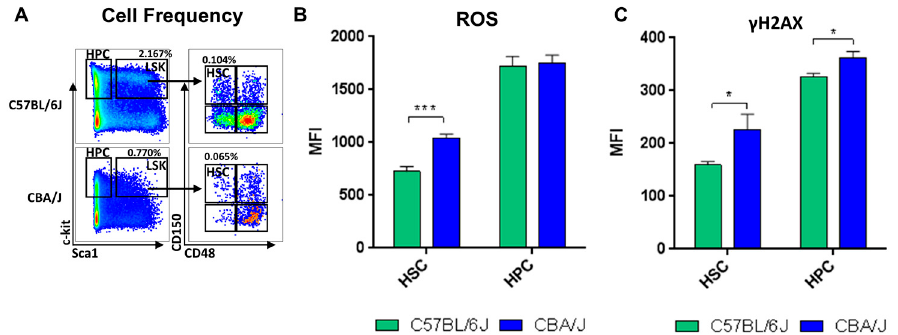
Figure 1. Comparative analysis of hematopoietic profiles of C57BL/6J and CBA/J mice. ( A ) Cell distribution and frequency of hematopoietic stem cells (HSCs) in hematopoietic stem and progenitor cells (HSPCs) ( B ) intracellular levels of endogenous reactive oxygen species (ROS) as measured by fluorescence intensity of 2 ′ 7 ′ -dichlorofluorescein ( C ) DNA strand breaks (as measured by fluorescence intensity of γ H2AX). Asterisks (*) denote significant ( p < 0.05) and (***)—( p < 0.001) difference from control. LSK: fraction of lineage negative, Sca1 positive, c-kit negative (LSK-) cells, from which HSCs were sorted ( n = 5/group).